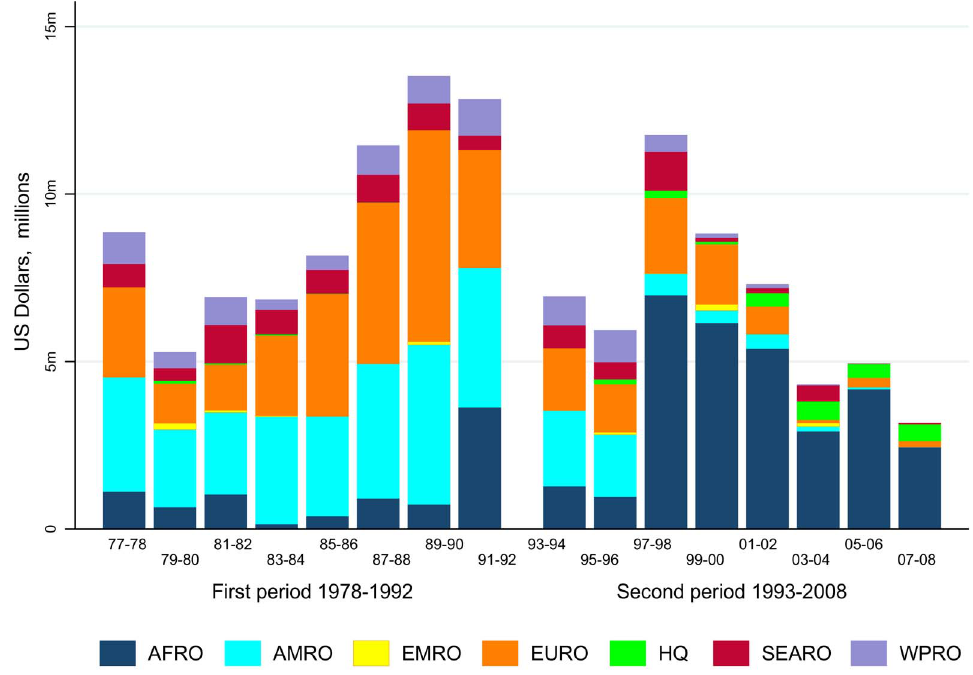
Fig. 2. Funding of malaria research by WHO region: 1977–1992 versus 1993–2008. AFRO, WHO region for Africa; AMRO, WHO region for the Americas; EMRO, WHO region for Eastern Mediterranean; EURO, WHO region for Europe; HQ, WHO Headquarters; SEARO, WHO region for South- East Asia; WPR, WHO region for the Western Pacific.